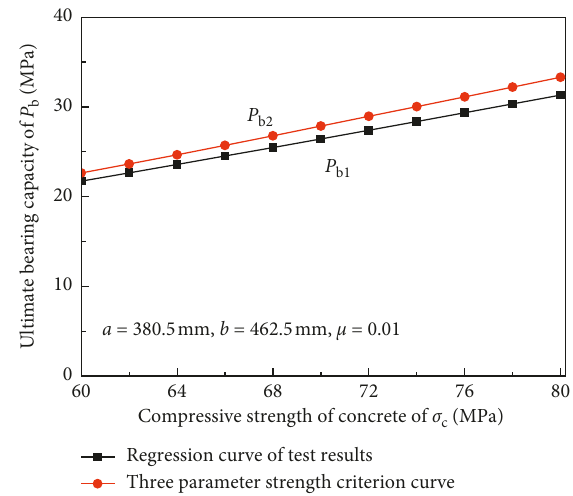
Regression curve of test results Three parameter strength criterion curve Figure 13: The relationship between ultimate bearing capacity and compressive strength when λ 0 . 216. (cid:31)